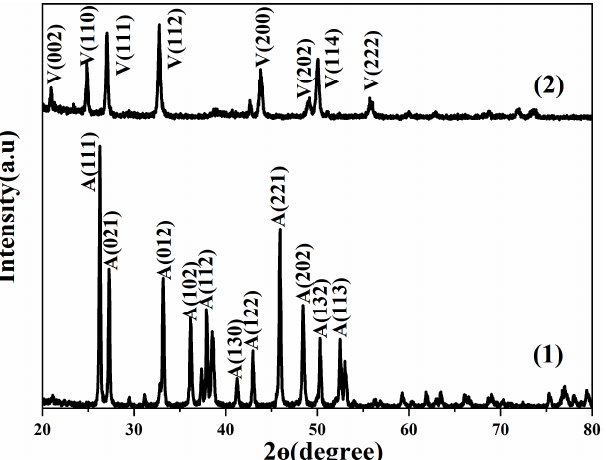
Figure 4. XRD diffraction spectra of calcium carbonate powder samples. (1) is aragonite, and (2) is vaterite.